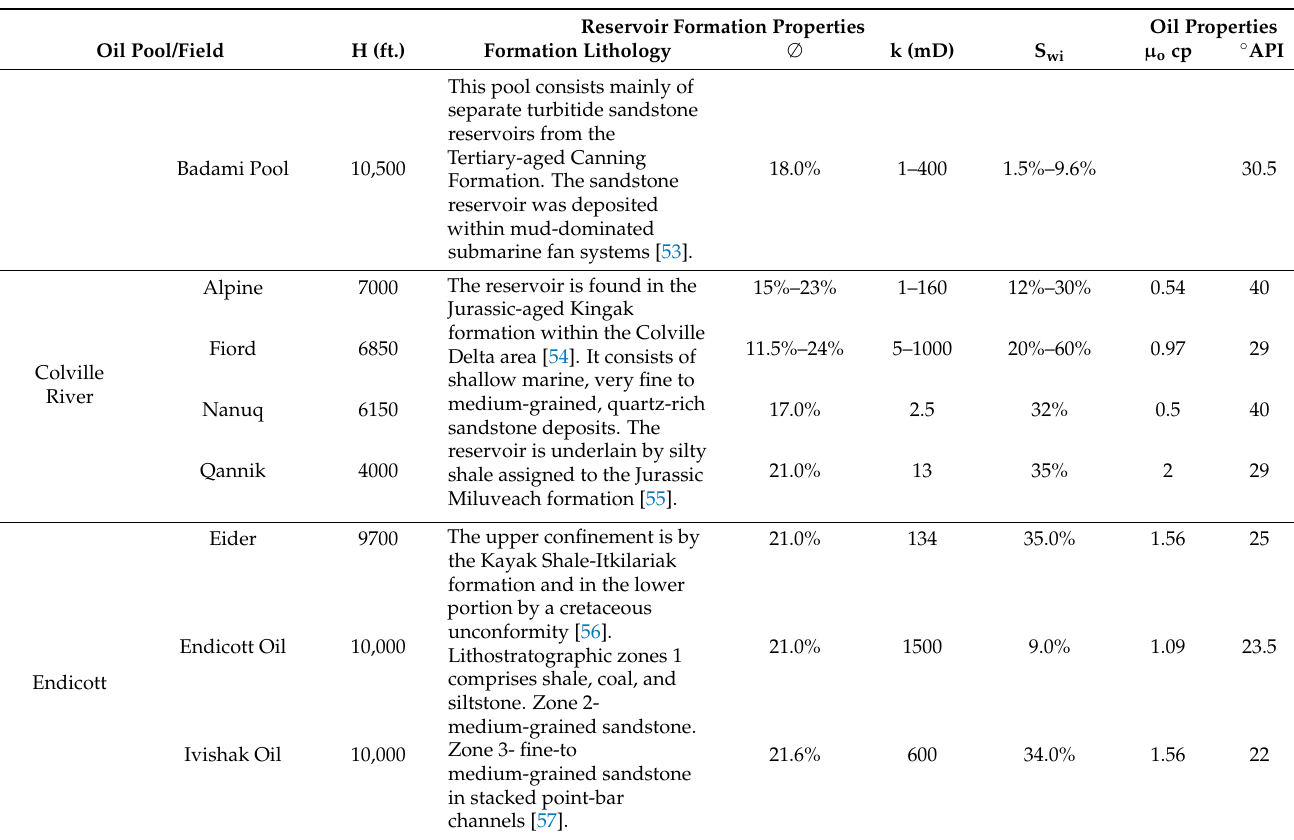
Table 1. Lithology, Rock and Fluid Properties of Alaskan Oil Pools. Reservoir Formation Properties Oil Properties Oil Pool/Field H